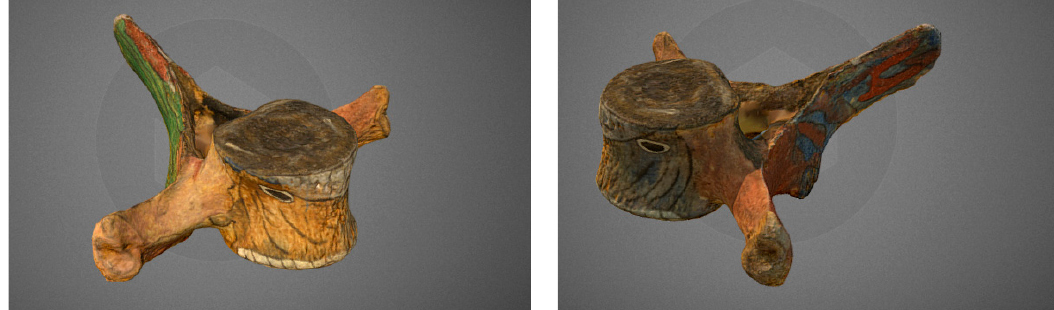
Figure 7. Three-dimensional (3D) representation of a painted cetacean vertebrae made in Cape Verde (right and left sides). This piece can be explored at the Story Map “Digital Humanities: Concepts turned into Visualisations”, as an output of the project CONCHA, and available at https://www.arcgis.com/apps/Cascade/index.html?appid=4f76506c0d354cd0a28be27aeba2ab5f.